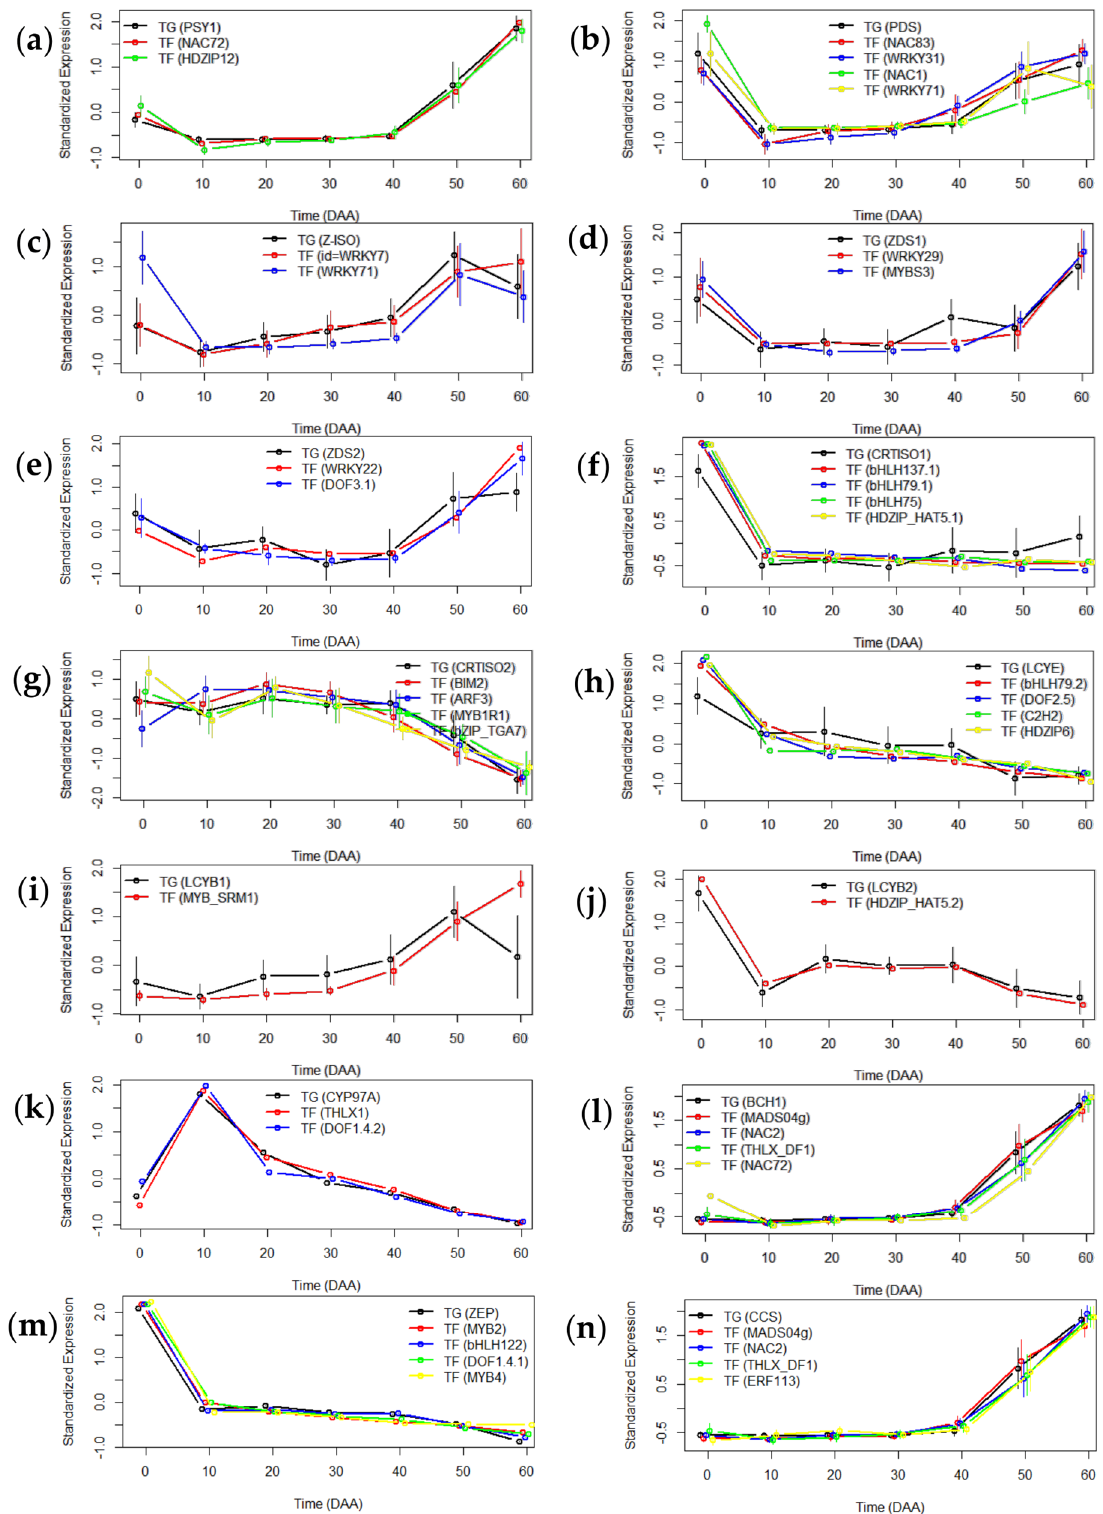
Figure 3. Average SEPs for TGs and the “TF winners”. ( a ) Phytoene synthase ( PSY1 ), ( b ) phytoene desaturase ( PDS ), ( c ) Z-carotene isomerase ( Z-ISO ), ( d ) Z-carotene desaturase 1 ( ZDS1 ), ( e ) Z-carotene desaturase 2 ( ZDS2 ), ( f ) lycopene isomerase 1 ( CTRTISO1 ), ( g ) lycopene isomerase 2 ( CRTISO2 ), ( h ) lycopene epsilon cyclase ( LCYE ), ( i ) lycopene beta cyclase 1 ( LCYB1 ), ( j ) lycopene beta cyclase 2 ( LCYB2 ), ( k ) cytochrome P450 97A ( CYP97A ) , ( l ) beta-carotene hydroxylase ( BCH1 ), ( m ) zeaxanthin epoxidase ( ZEP ), and ( n ) capsanthin/capsorubin synthase ( CCS ).